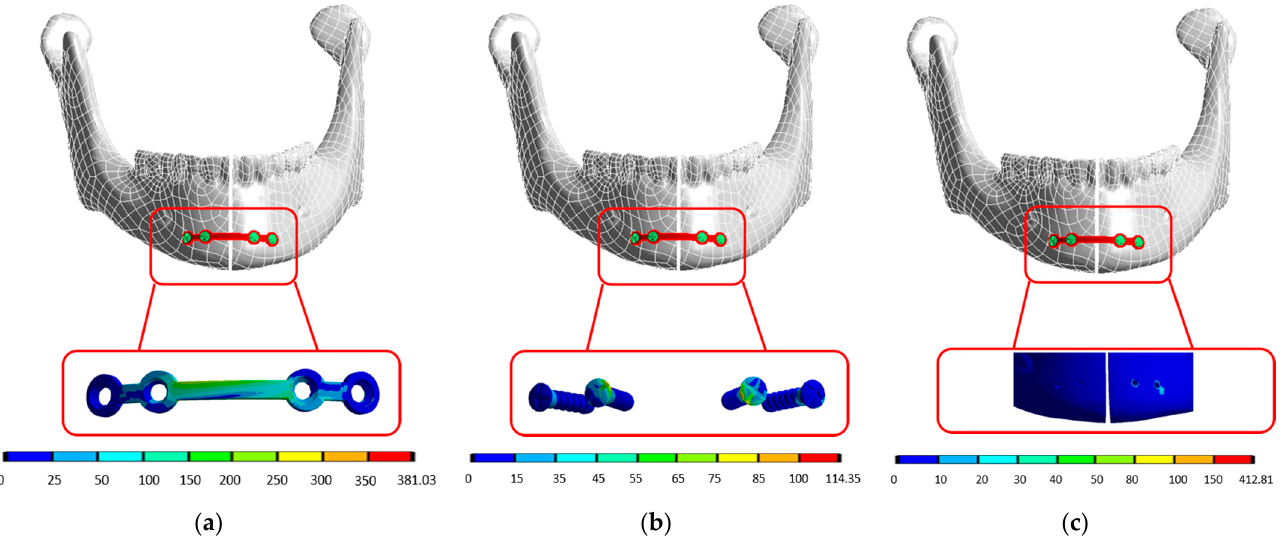
Figure 2. Stress distribution of S4HP. ( a ) plate; ( b ) screws; ( c ) screw holes. (Unit: MPa).